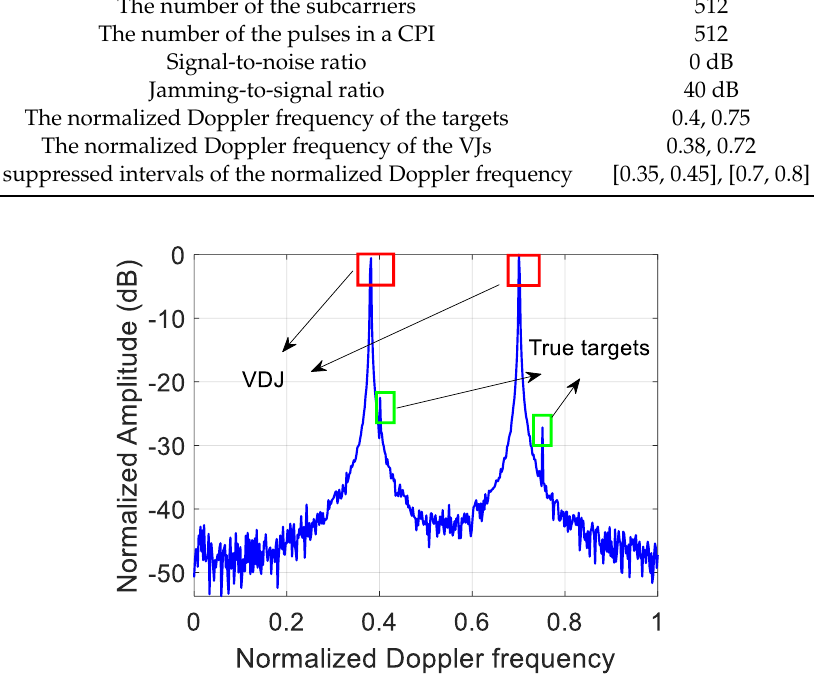
Figure 4. The countermeasure effect in the presence of the VDJ.